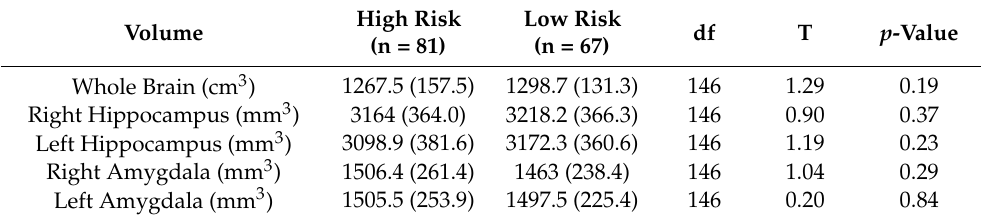
Table 2. Overall Volumes of the Hippocampus and